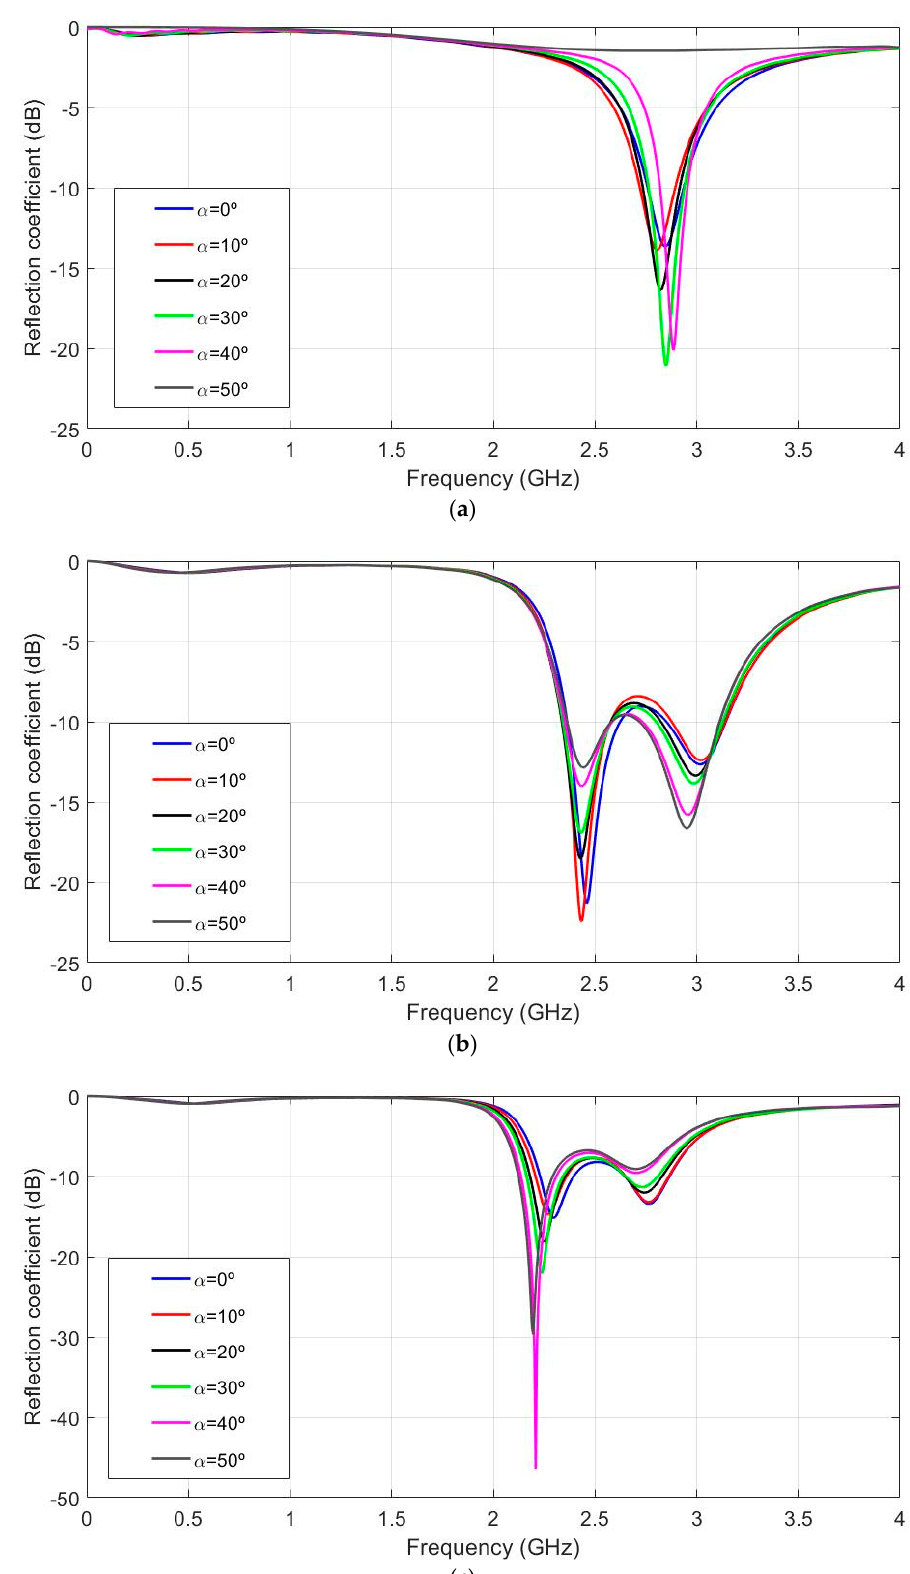
Figure 5. Simulated reflection coefficient for the different values of the curvature angles, α from 0° to 50° in 10° steps, ε r = 1.3 and tan δ = 0.058. ( a ) hs = 2 mm, ( b ) hs = 6 mm and ( c ) hs = 10 mm.